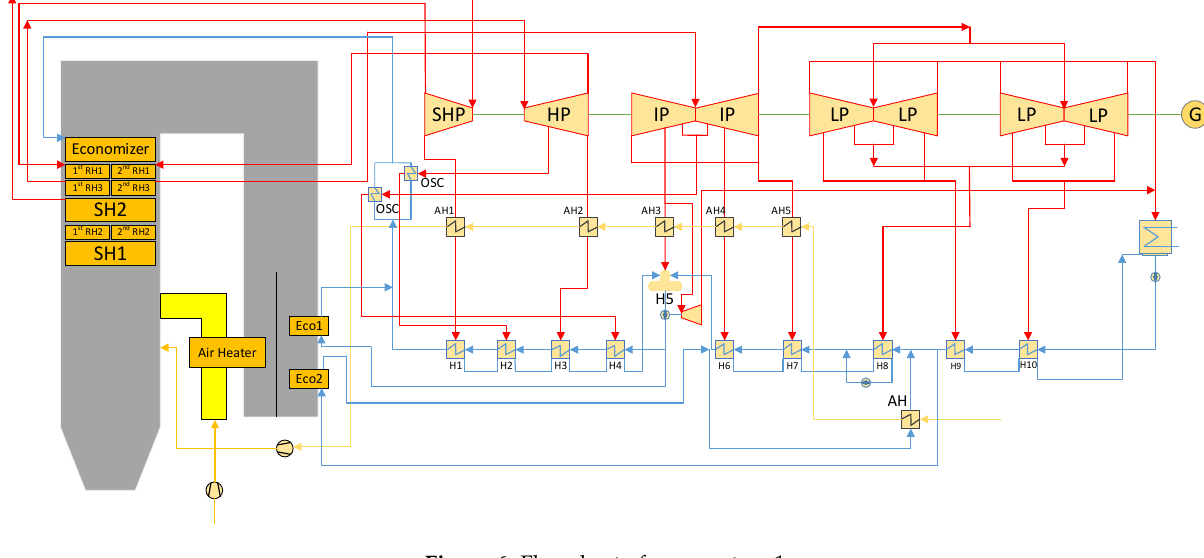
Figure 6. Flowchart of new system 1.